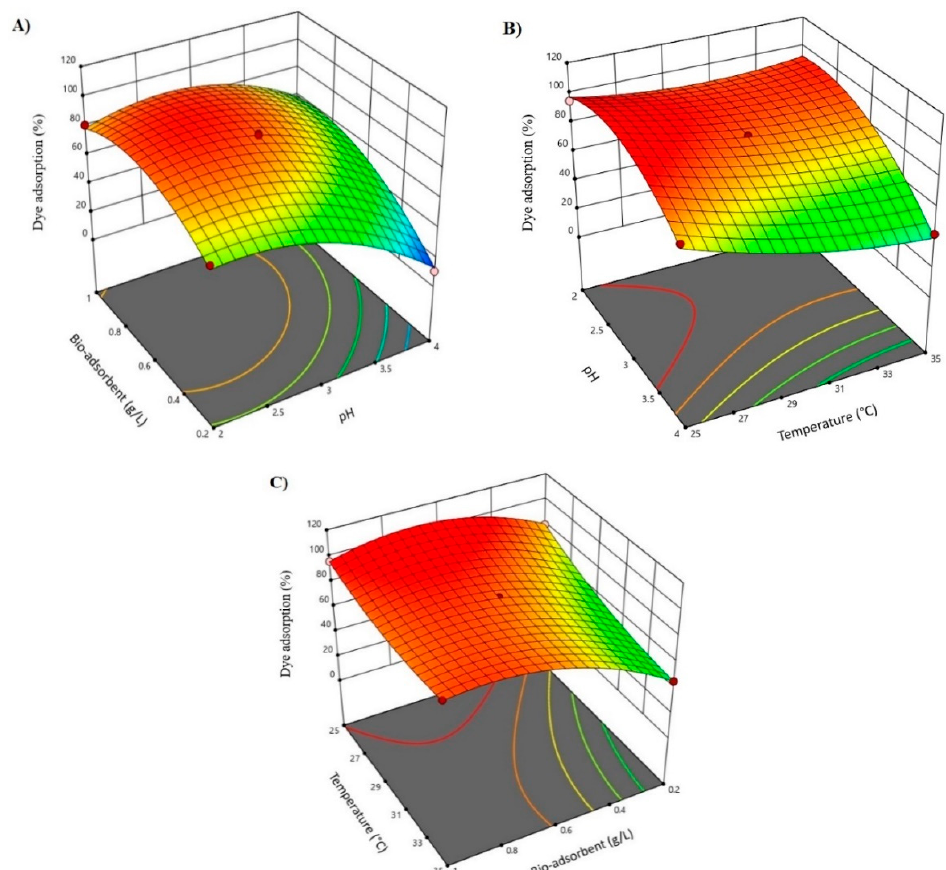
Figure 2. Response surface for dye bio-adsorption by orange seed powder. ( A ) pH and bio-adsorbent dose. ( B ) pH and temperature. ( C ) bio-adsorbent dose and temperature. In each case, the third variable was kept at its center point value.